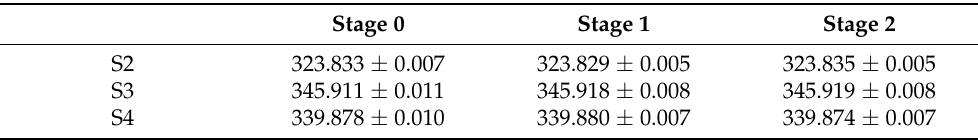
Comparative values of the elevations and their very small deviations: Table A11.